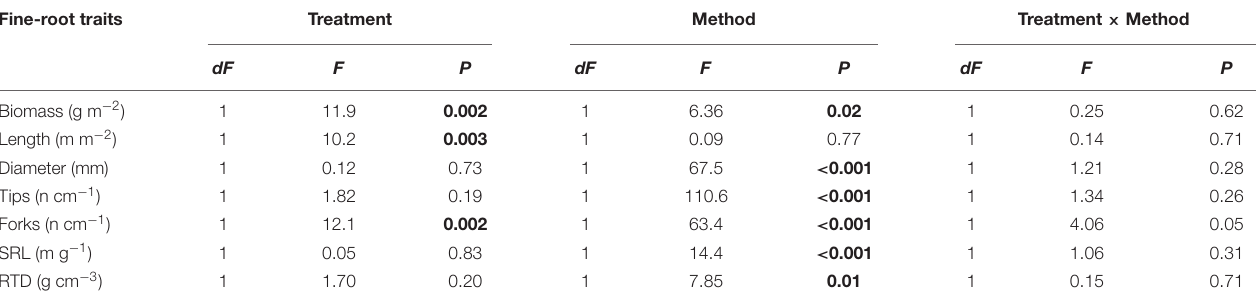
TABLE 3 | Results of two-way ANOVA testing the effect of the irrigation treatments (dry vs. irrigated) and the fine-root sampling methods (ingrowth cores vs. soil cores) on fine-root traits in 2016. Fine-root